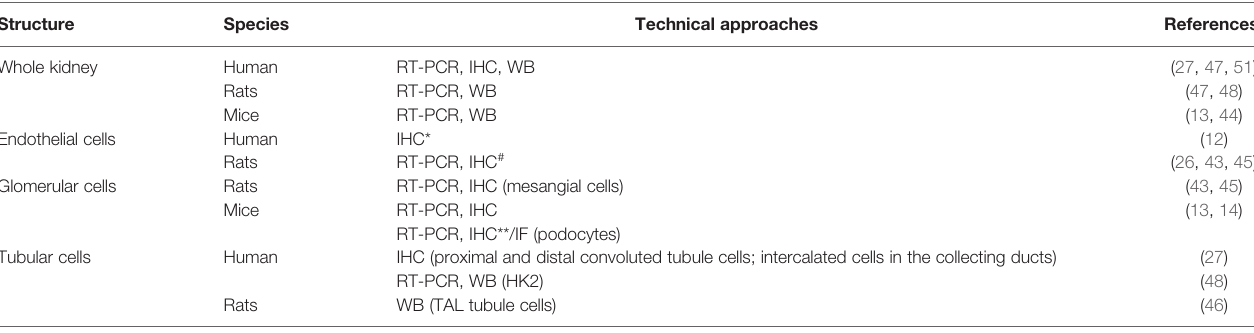
TABLE 1 | CB1R expression within healthy kidneys. Structure